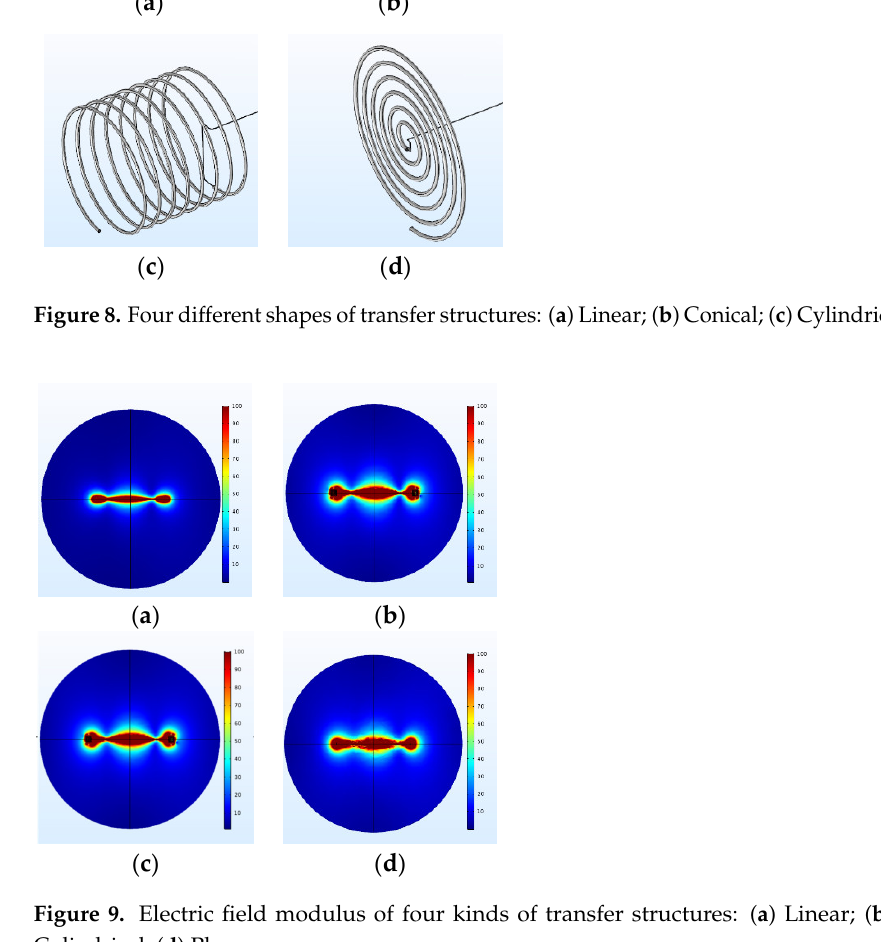
Figure 8. Four different shapes of transfer structures: ( a ) Linear; ( b ) Conical; ( c ) Cylindrical; ( d ) Pla- nar.